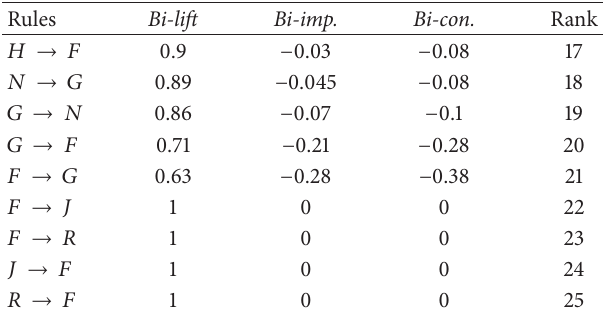
Table 7: The sort of negative association rules and meaningless rules.